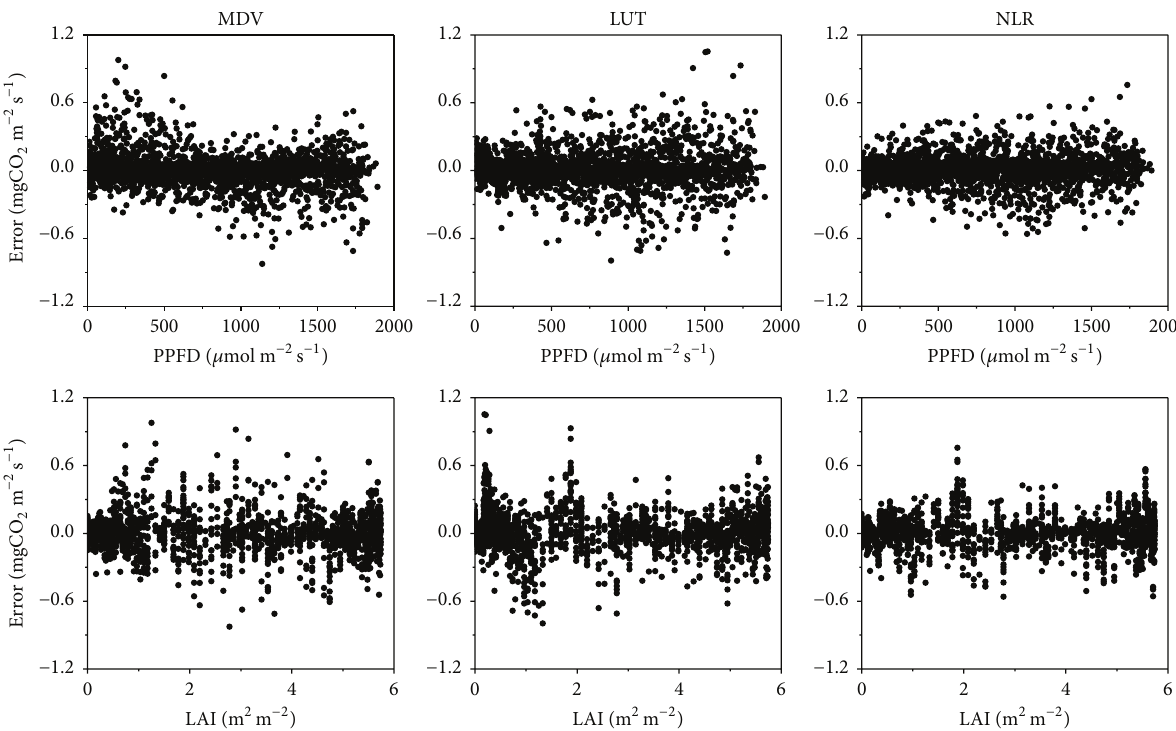
Figure 8: The relationship between bias error and PPFD and LAI in day time, taking 65% gaps at rice site as an